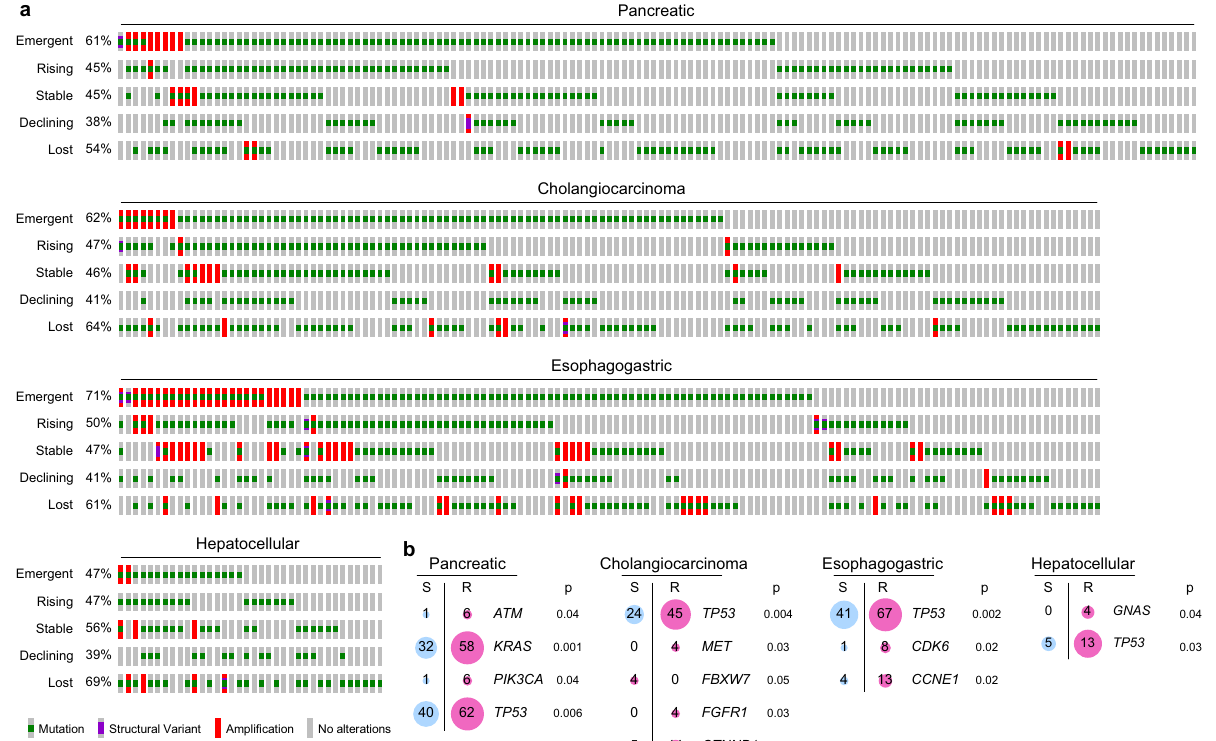
Fig. 1 | Dynamics in ctDNA alterations in refractory gastrointestinal cancers. a Oncoprint plots depict nonsynonymous ctDNA alterations categorized as either emergent, rising, stable, declining or lost across individual with gastrointestinal cancers. b Enrichment of resistance (R) or sensitive (S) alterations in genes with a